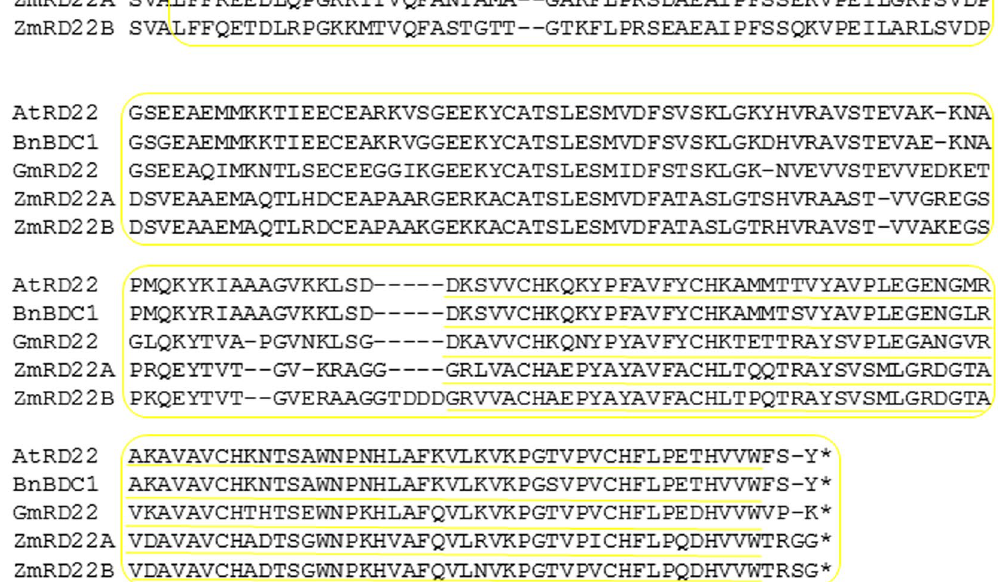
Figure 1. Sequence alignment and domain organization of five BURP domain-containing proteins. At5G25610 (AtRD22), AAQ57584 (BnBDC1), Glyma06g08540 (GmRD22), GRMZM2G446170 (ZmRD22A) and GRMZM2G800586 (ZmRD22B) were aligned, resulting in 136 identical sites (29% identity) and a pairwise identity of 52.4%. Similar domains and structural components were identified and are indicated as follows: the hydrophobic signal peptides are encircled in blue, the conserved amino acids in the conserved region are shown in green, The TxV (x is any amino acid) repeats are shown in red, the BURP-domains are shown in yellow and the conserved motif of the BURP-domain is underlined with